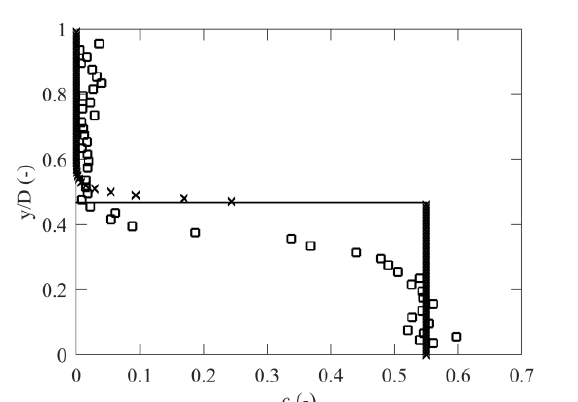
Fig. 7. Deposition limit velocity of SP090 slurry flow in pipe at different inclination angles. Legend: o = experiment ( C vd,max = 0.26), + = prediction by layered model ( C vd,max = 0.26), square = experiment ( C vd,max = 0.37), x = prediction by layered model ( C vd,max =